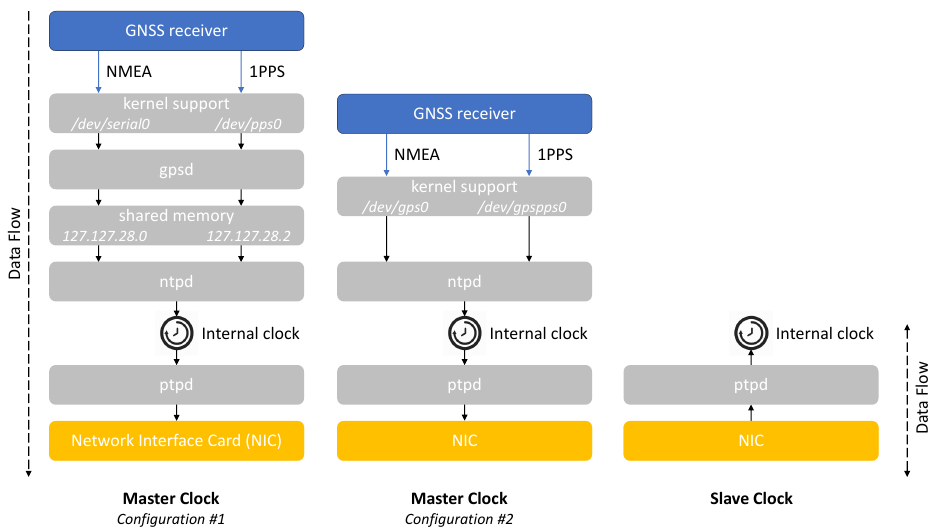
Figure 2. Possible software stack and configurations for Master Clock and Slave Clock